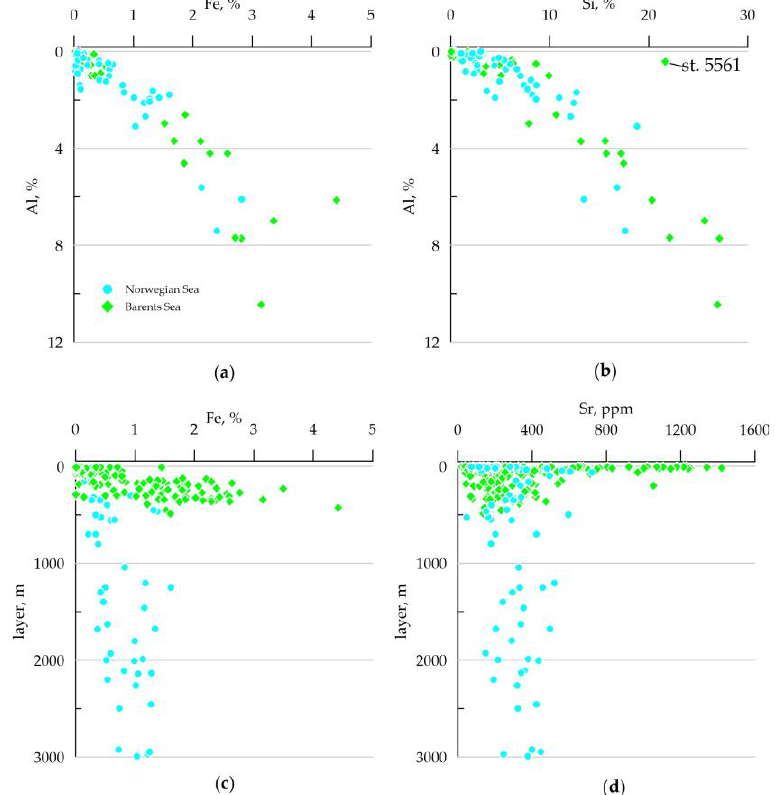
Figure 6. Scattering diagrams between ( a ) Al and Fe; ( b ) Al and Si; ( c ) depth of sampling and Fe; ( d ) depth of sampling and Sr.